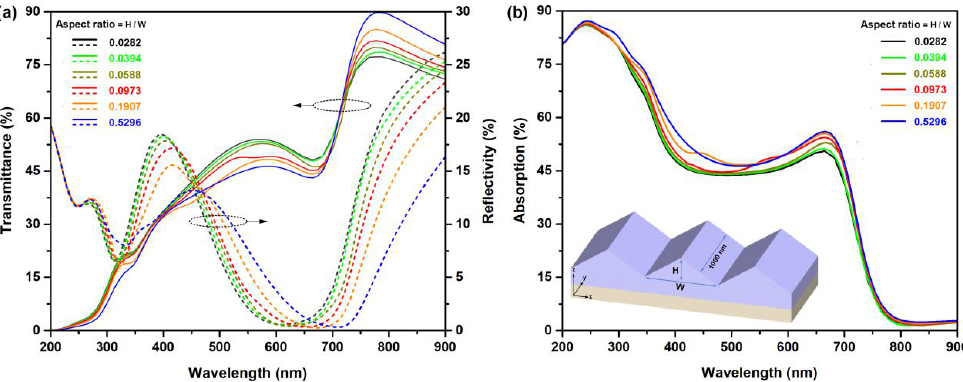
Figure 6. ( a ) Transmission and reflection spectra of the textured surface with different aspect ratios of the SANR structures and ( b ) corresponding absorption spectra. The inset demonstrates the structural parameters of the numerical model; the specific values are listed in Table 1. Table 1. Specific parameters for the equivalent SANR structures with different aspect ratios.